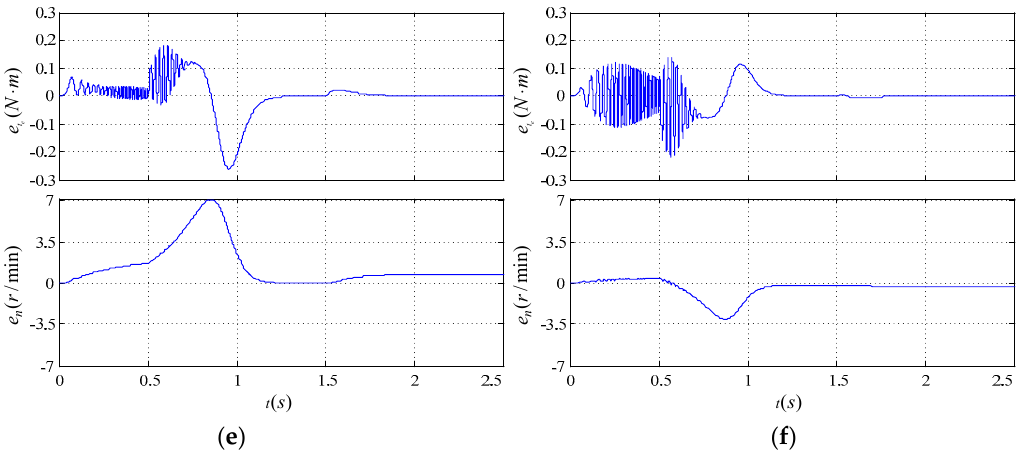
Figure 6. Dynamic response errors between parallel model, traditional model, or series model. ( a ) Traditional model stator current error; ( b ) Series model stator current error; ( c ) Traditional model flux linkage error; ( d ) Series model flux linkage error; ( e ) Traditional model torque and speed error; ( f ) Series model torque and speed error.